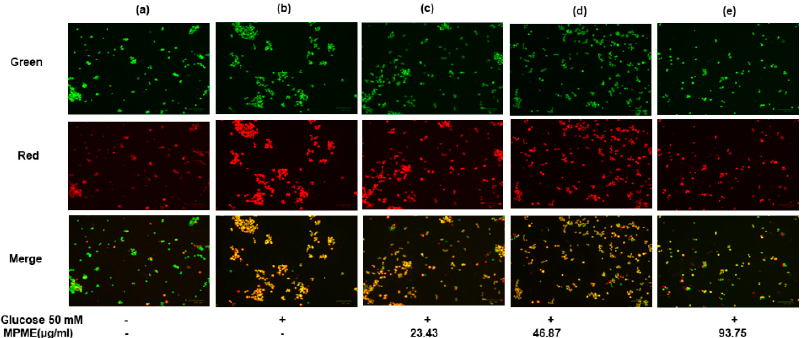
Figure 4. Effect of methanolic heartwood extract of Pterocarpus marsupium (MPME) on high glucose